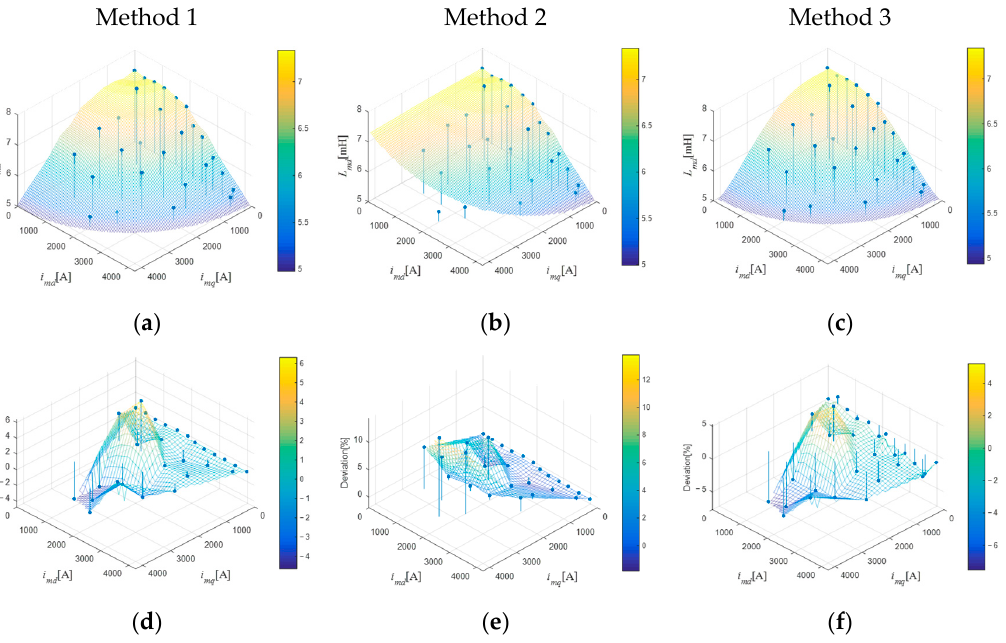
Figure 10. Comparison between the obtained experimental and analytical results with corresponding deviations for the d -axis magnetizing inductance: ( a , d ) Method 1 (Levi); ( b , e ) Method 2 (Kaukonen); ( c , f ) Method 3 (El-Serafi & Wu).